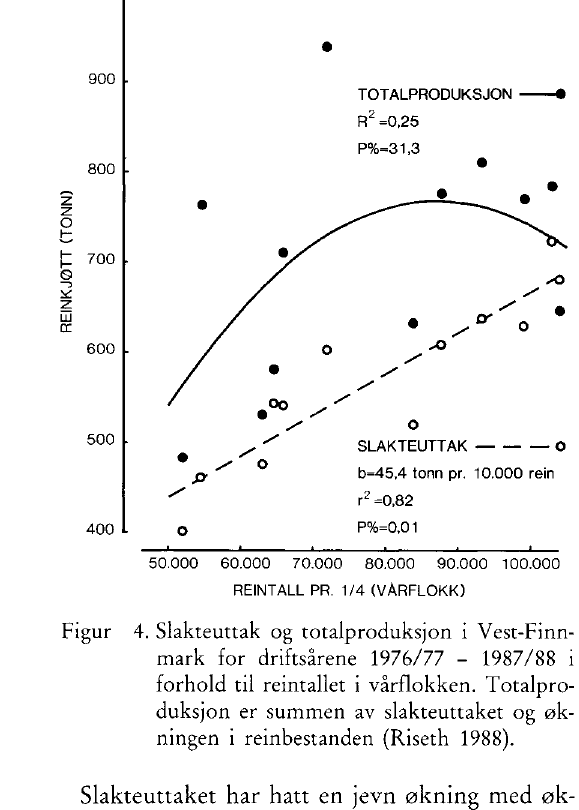
Figur 4. Slakteuttak og totalproduksjon i Vest-Finn- mark for driftsårene 1976/77 - 1987/88 i forhold til reintallet i vårflokken. Totalpro duksjon er summen av slakteuttaket og øk ningen i reinbestanden (Riseth